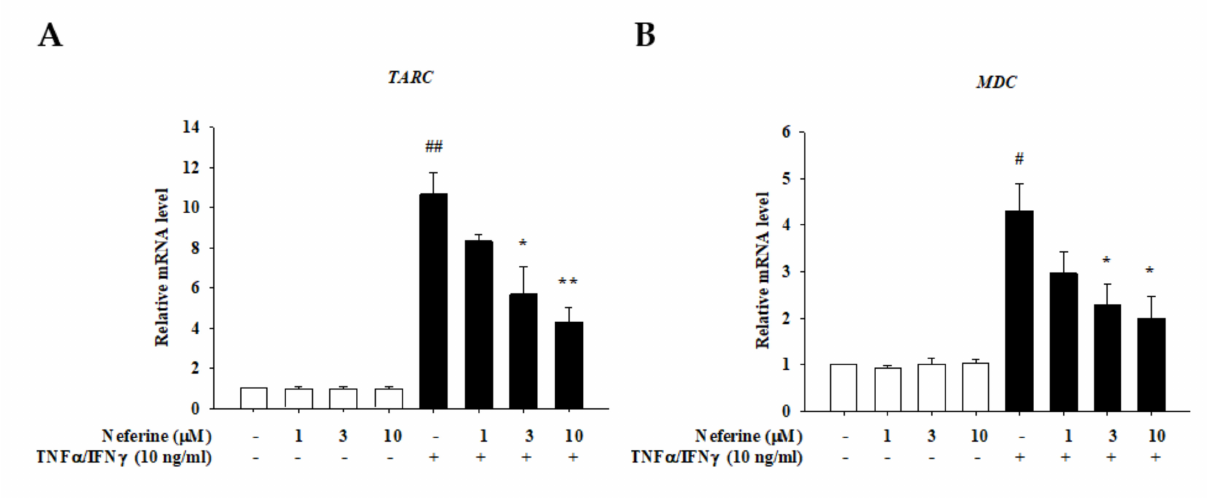
Figure 2. The effect of neferine on the mRNA expression levels of cytokines in TNF- α /IFN- γ -stimulated HaCaT cells. HaCaT cells were pretreated with different concentrations of neferine (1, 3, and 10 µ M) for 20 min, and then the cells were treated with TNF- α /IFN- γ (10 ng/mL) for 1 h or 24 h (for TSLP). Total RNA was isolated, and the mRNA expression level of ( A ) IL-1 β , ( B ) IL-6, ( C ) IL-8, and ( D ) TSLP was determined using qPCR. Values represent the mean ± SEM from three independent experiments. ## p < 0.01 compared with the no-treatment condition; * p < 0.05 and ** p < 0.01 compared with the TNF- α /IFN- γ treatment